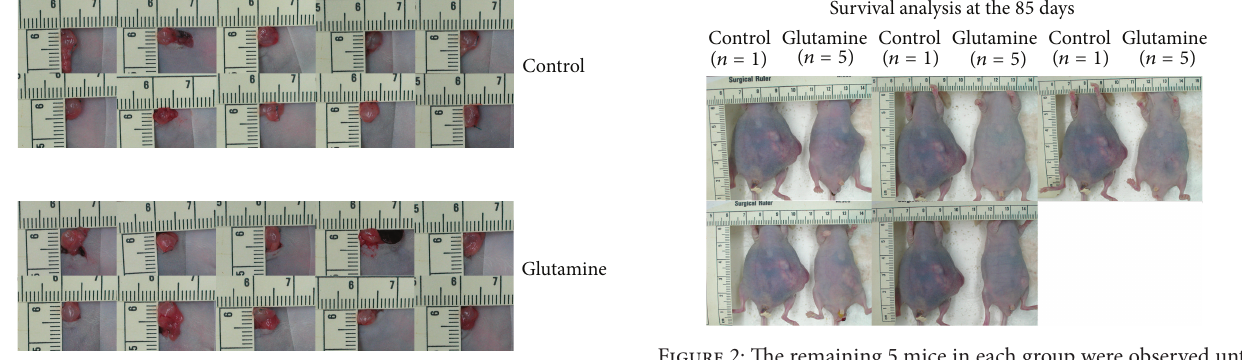
Figure1:ExperimentalPCwasgeneratedbydirectorthotopicinjec- tion of PANC-1 cells into the pancreatic tail. Animals underwent laparotomy to confirm tumor growth reaching up to 5 mm on the 10th day.